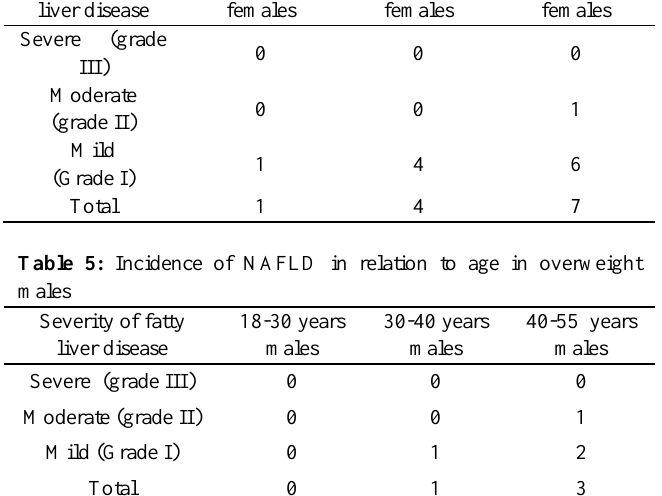
Table 4: Incidence of NAFLD in relation to age in overweight females Severity of fatty liver disease